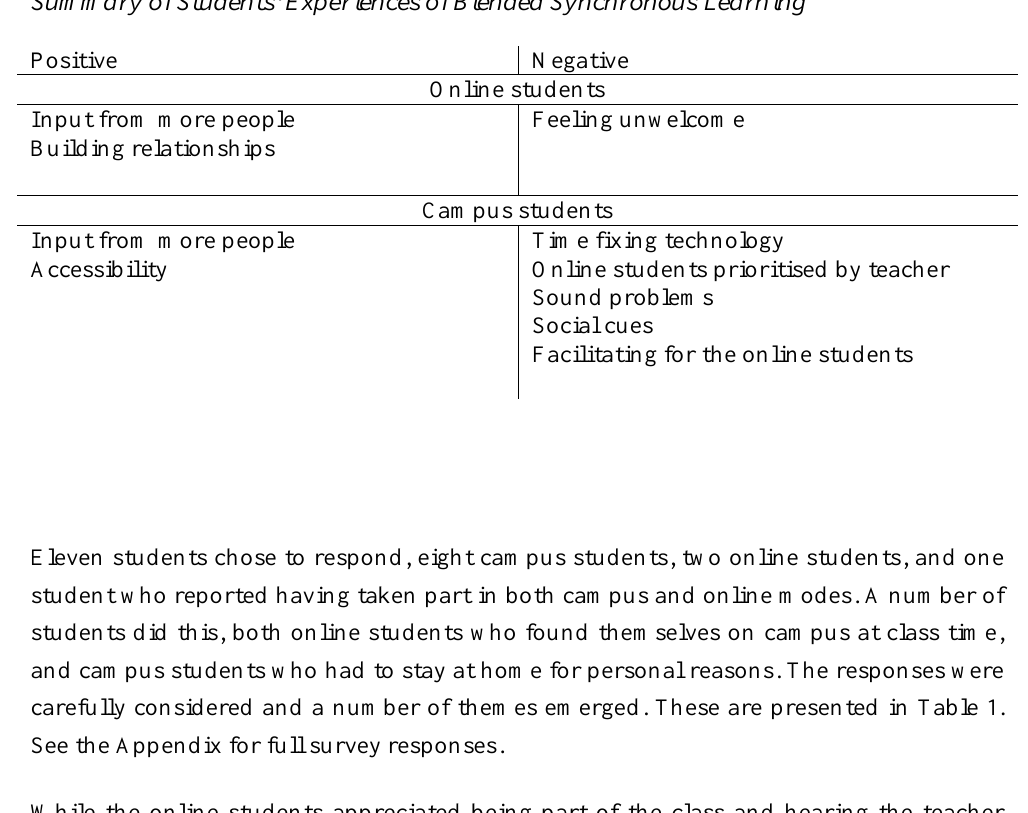
Summary of Students’ Experiences of Blended Synchronous Learning